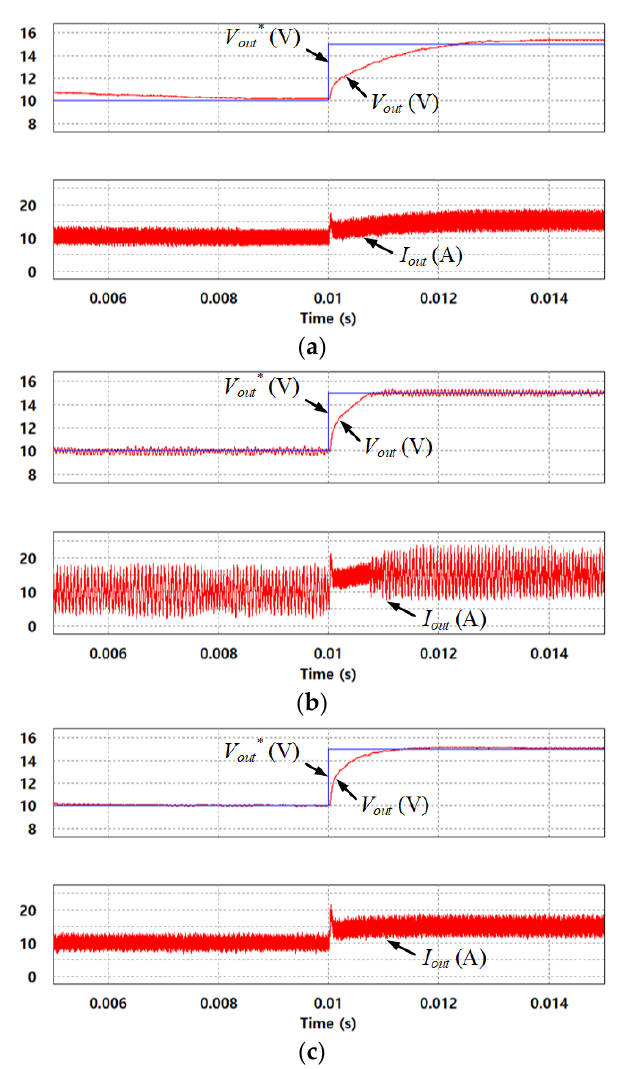
Figure 12. Simulation results of the PSFB-CT converter using three different controllers. ( a ) PI controller; ( b ) SMC; ( c ) proposed hybrid fuzzy SMC.